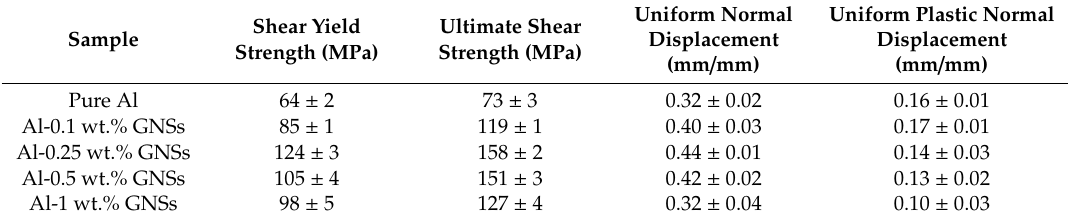
Table 3. Information related to shear yield strength (MPa), ultimate shear strength (MPa), uniform normal displacement (mm / mm), and uniform plastic normal displacement (mm / mm) of fabricated samples with di ff erent GNS weight